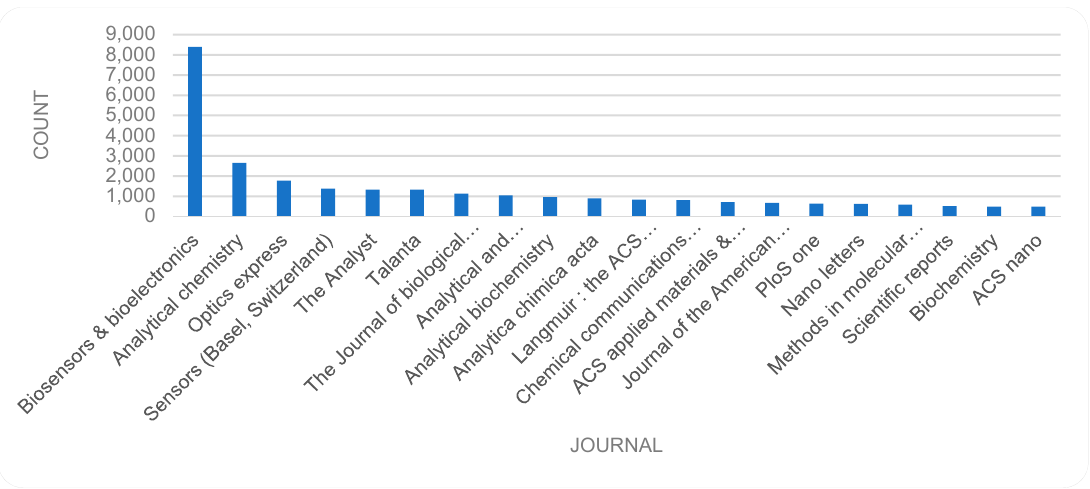
Figure 12. Journal Titles (top 20).